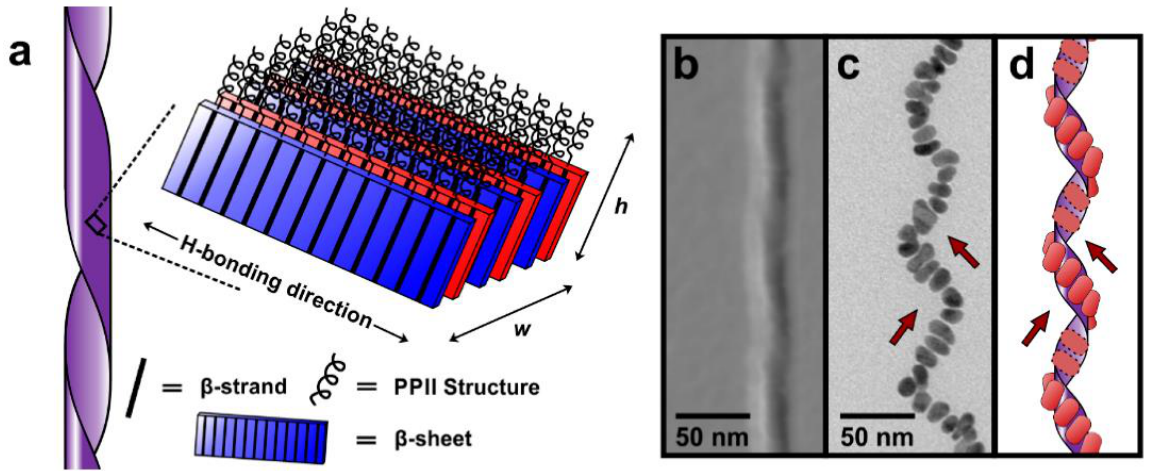
Figure 4. ( a ) Cartoon showing peptide assembly into a nanoribbon. ( b ) AFM image of the resulting assembled fiber. ( c ) TEM image of the gold nanorods oriented (arrows) into a helical pattern. ( d ) Proposed model of the gold nanorods associated to the outer surface of the peptide ribbon. Adapted with permission from [13]. Copyright © 2016, American Chemical Society.